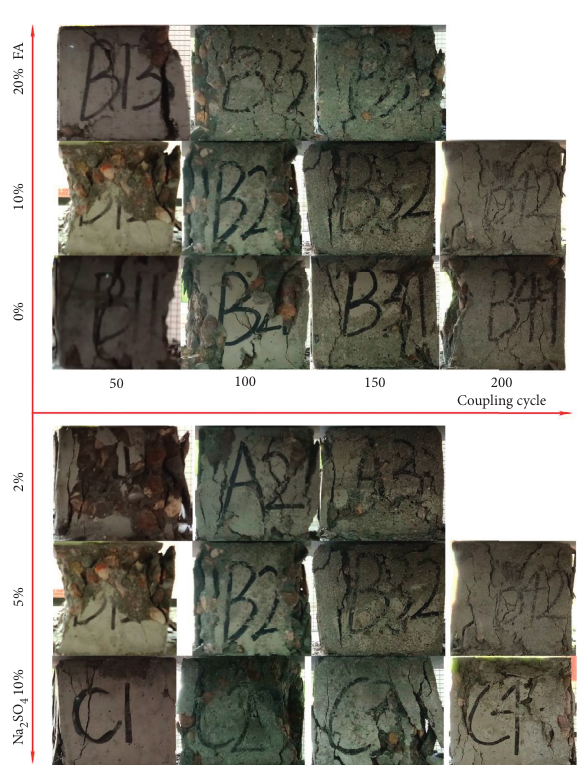
Figure 5: Compressive failure morphology of concrete with dif- ferent contents of fly ash after coupling